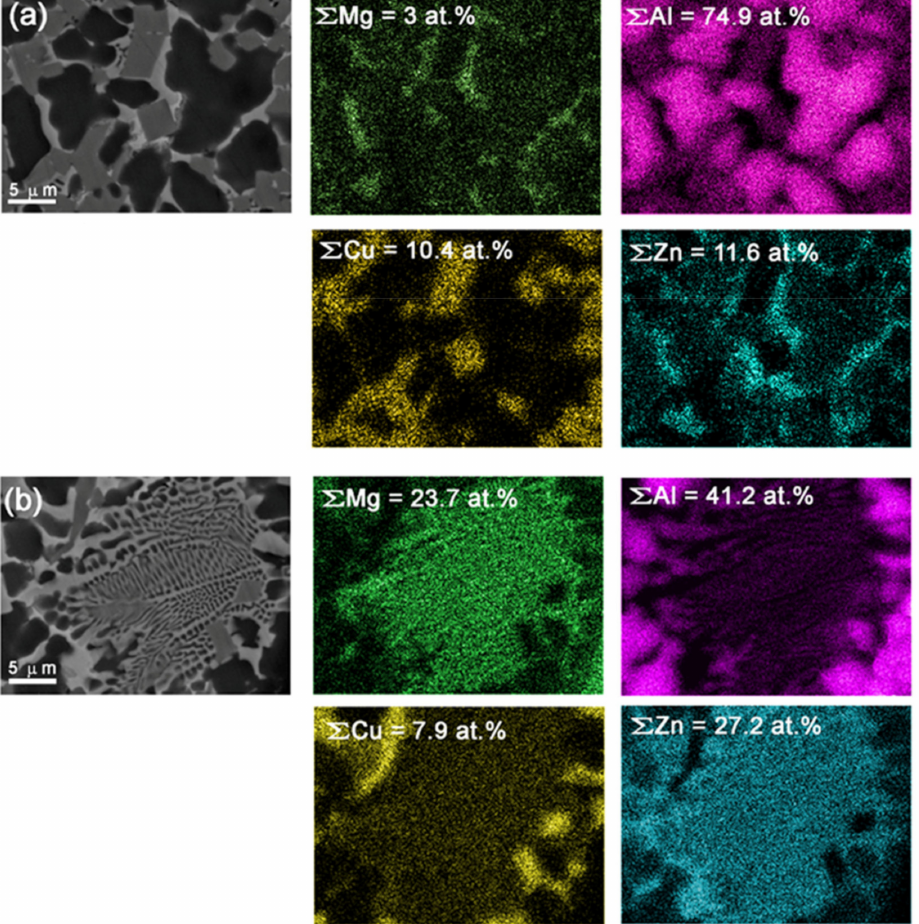
Figure 4. SEM BSE images of α -Al(Cu,Zn), Al 2 Cu IMCs in a Mg-Zn solid solution matrix ( a ), and Zn+MgZn eutectics ( b ) in the bottom part of SZ with corresponding EDS element distribution